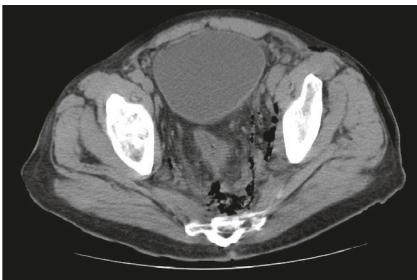
Figure 2: Axial CT image showing gas around the left rectum to the sacrum and ascending anterior along the left internal pelvic sidewall.